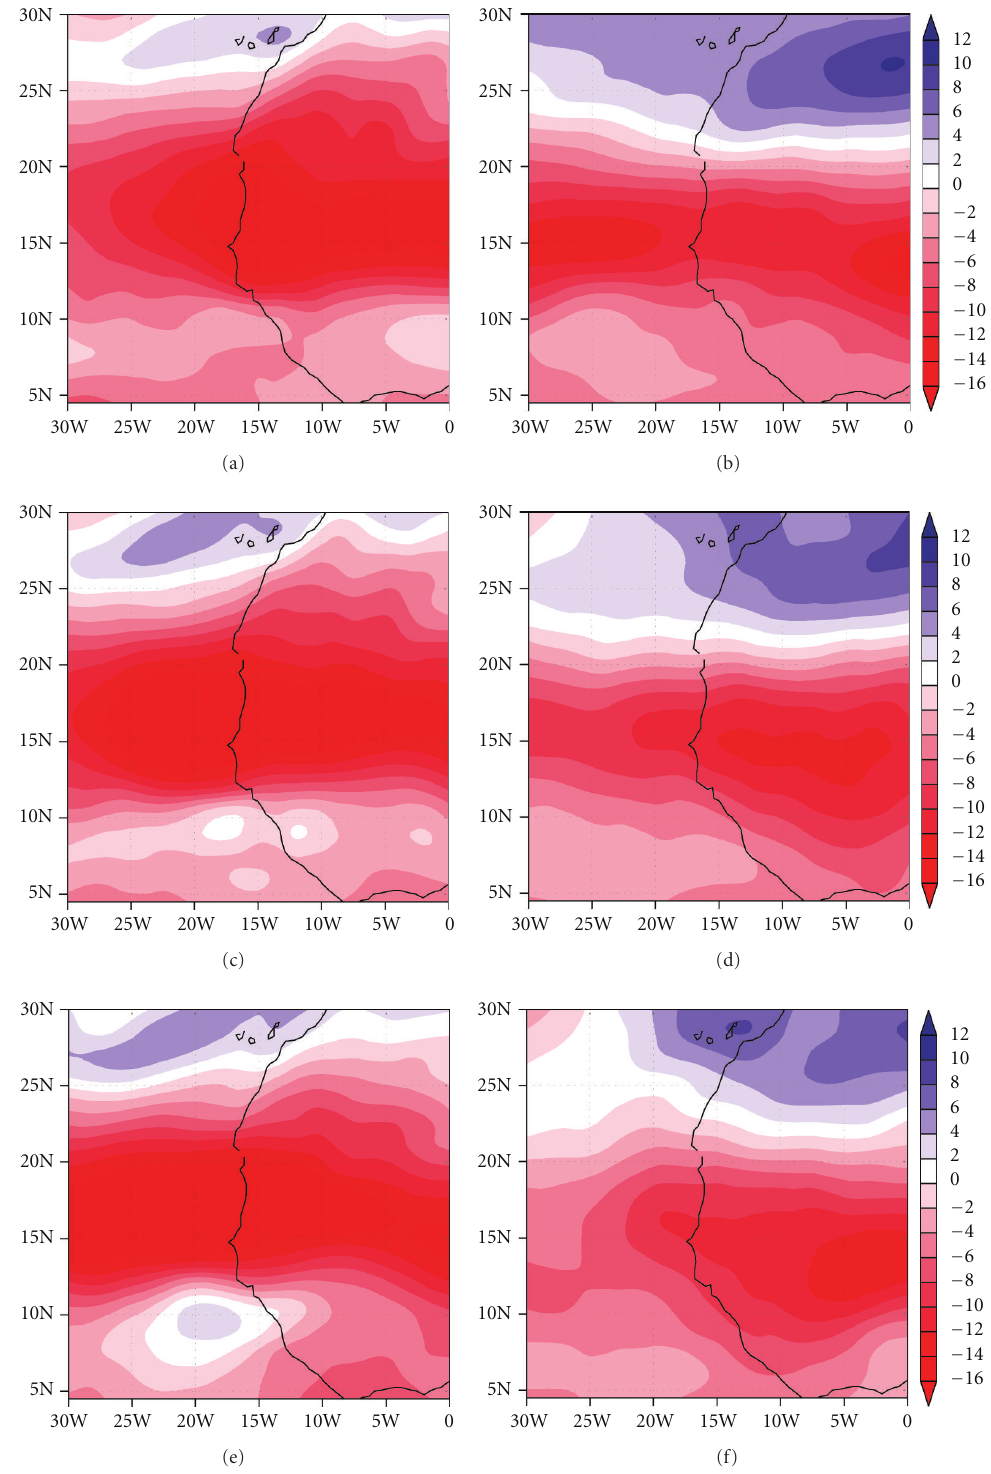
Figure 3: 600 hPa zonal winds for times prior to, during, and after MCS event passages averaged to represent TCP (a), (c), and (e) and NTCP (b), (d), and (f) events. Darker reds indicate stronger easterly